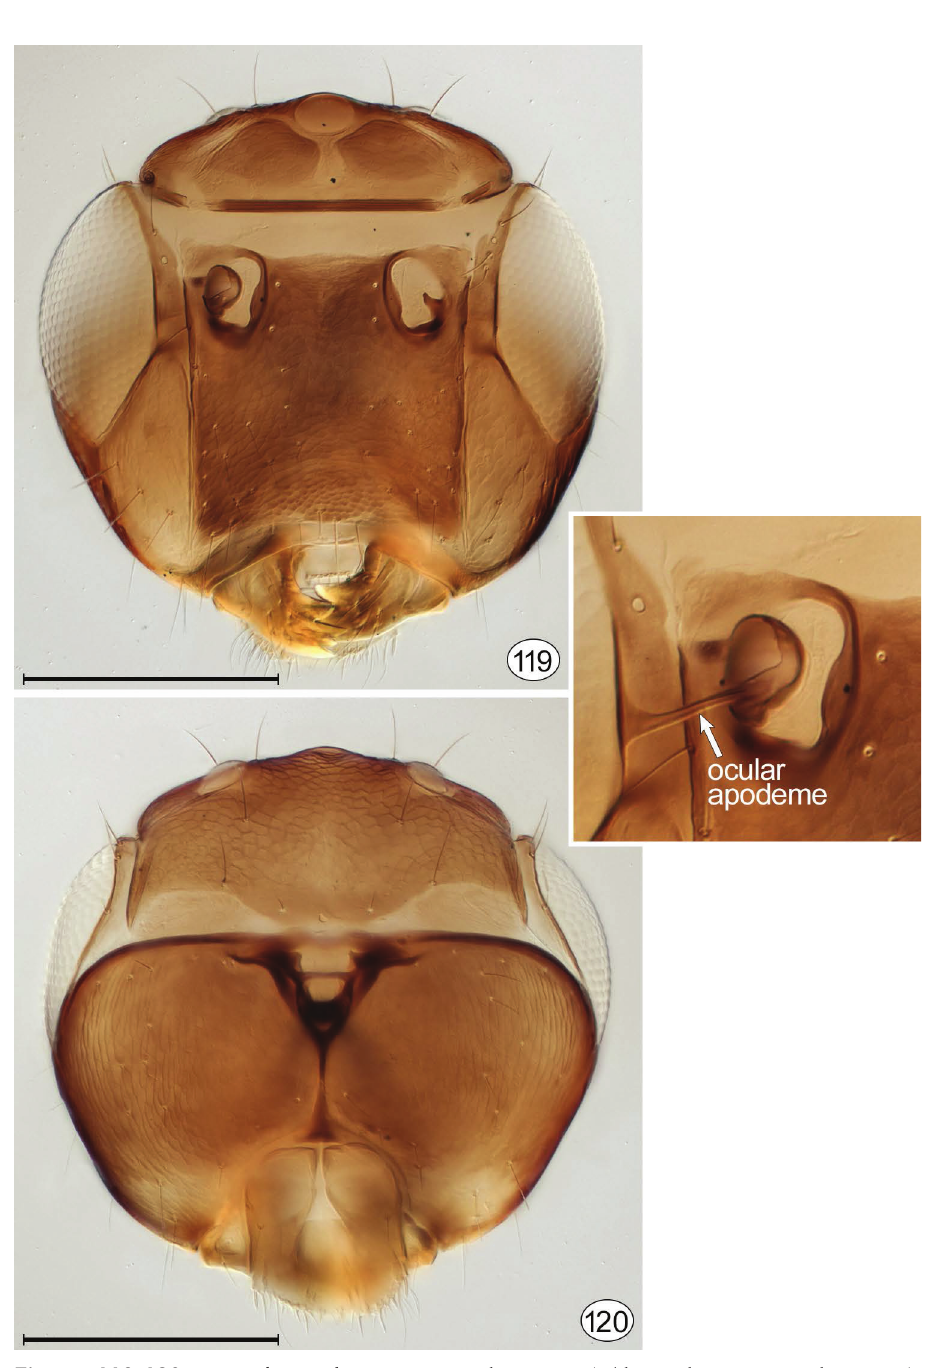
Figures 119, 120. Neotriadomerus longiovipositor , male paratype (14 km W. by N. Hope Vale Mission). 119 head, anterior (inset shows ocular apophysis or apodeme) 120 head, posterior. Scale bar = 200